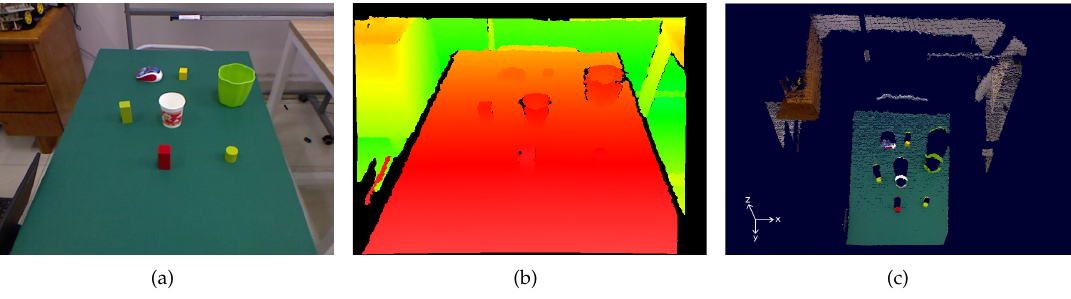
Figure 1. The RGB image ( a ), colored depth image ( b ), colored point cloud ( c ) of a sample